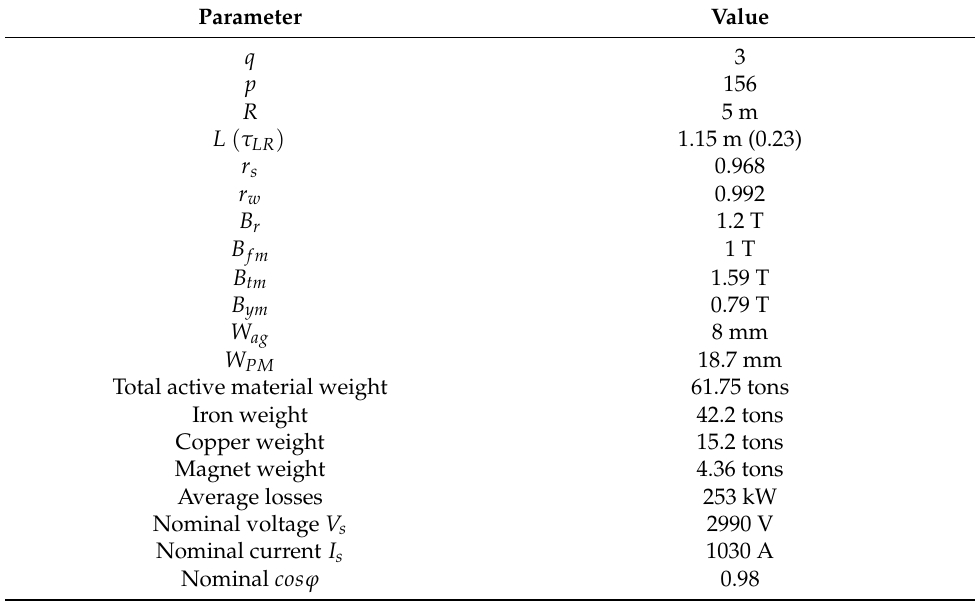
Table 5. Optimal machine parameters.